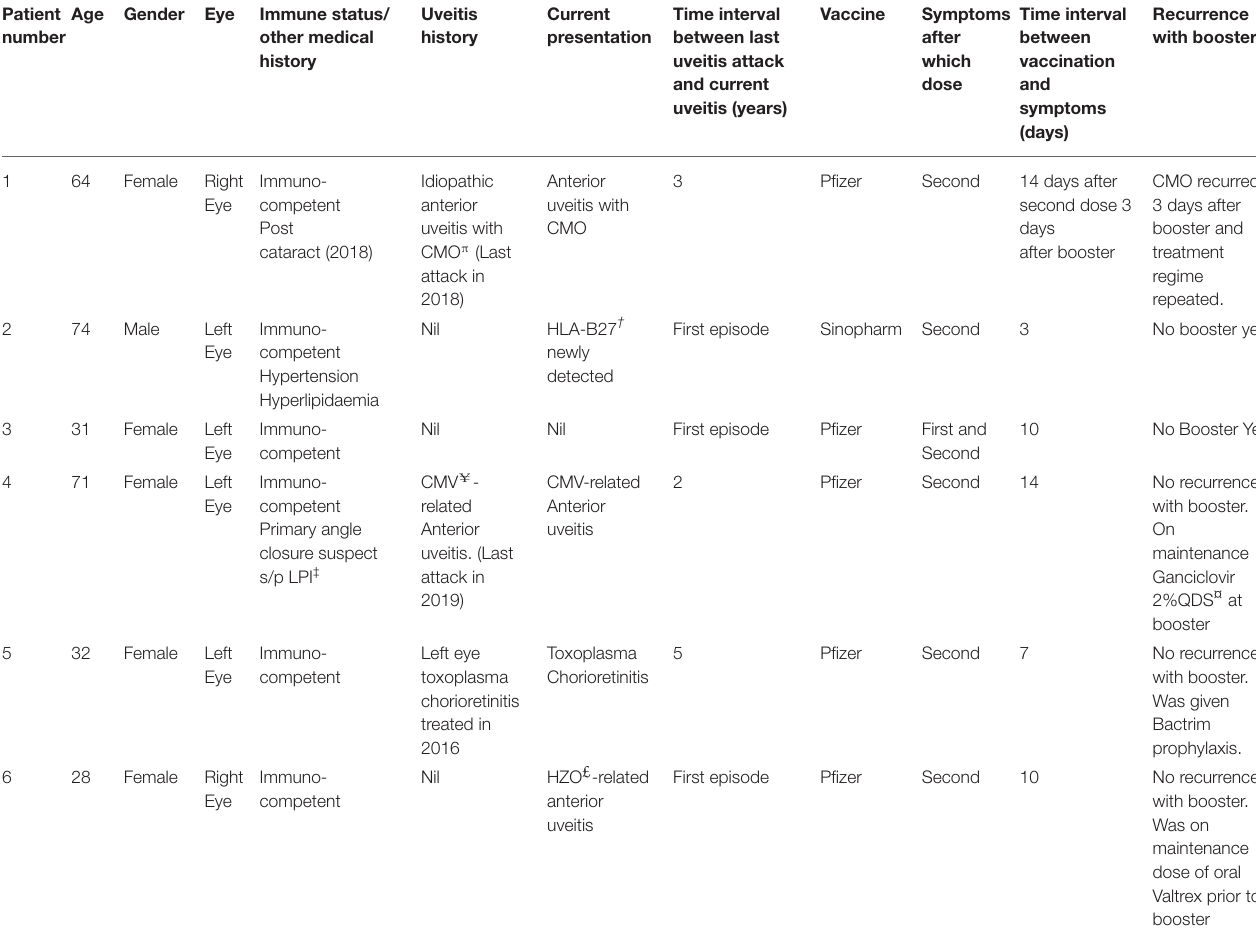
TABLE 1 | Patient demographics, diagnosis and vaccine related findings. Patient Age Gender Eye Immune status/ number other